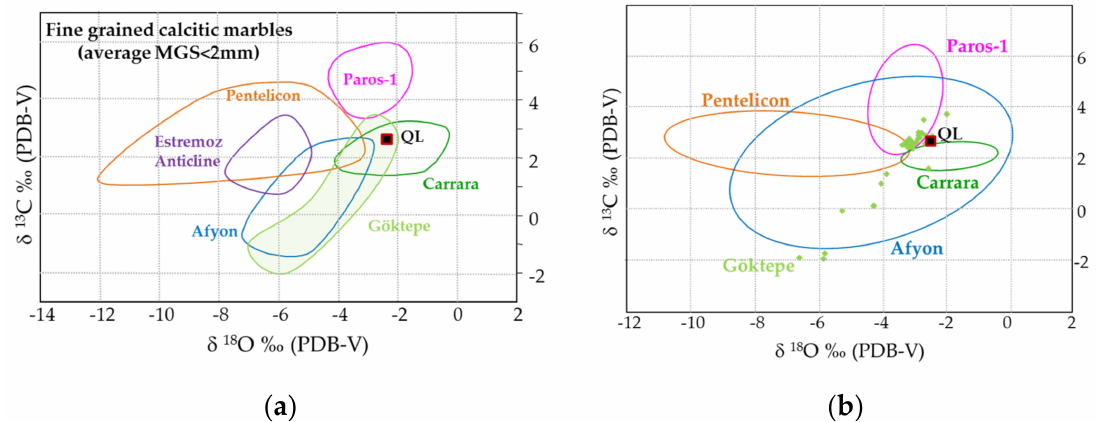
Figure 7. Isotopic C and O signature of the archaeological sample QL (red and black square) plotted on two different diagrams for classical fine grained marbles: ( a ) isotopic diagram adapted from [32] with data from [5,14,15,17]; ( b ) scatterplot of the C and O isotope compositions of the Göktepe white marble adapted from [15], with the probability distribution (99%) of isotope data represented by ellipses adapted from